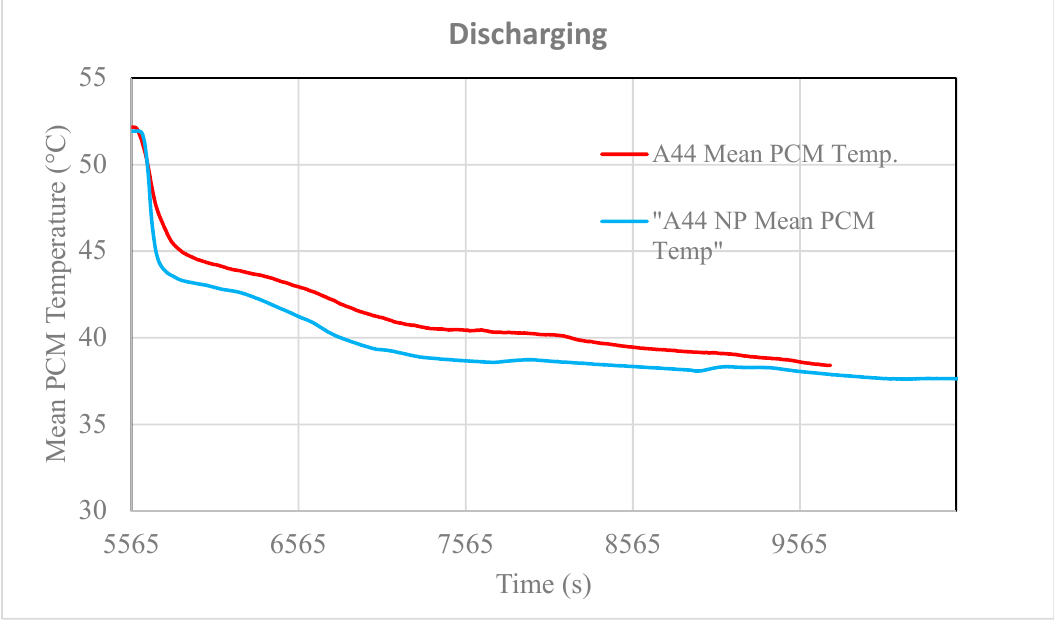
ChemEngineering 2019 , 3 , x FOR PEER REVIEW Figure 12. Mean temperature evolution of pure A44 and A44 + NP upon charging. Figure 12. Mean temperature evolution of pure A44 and A44 + NP upon charging.